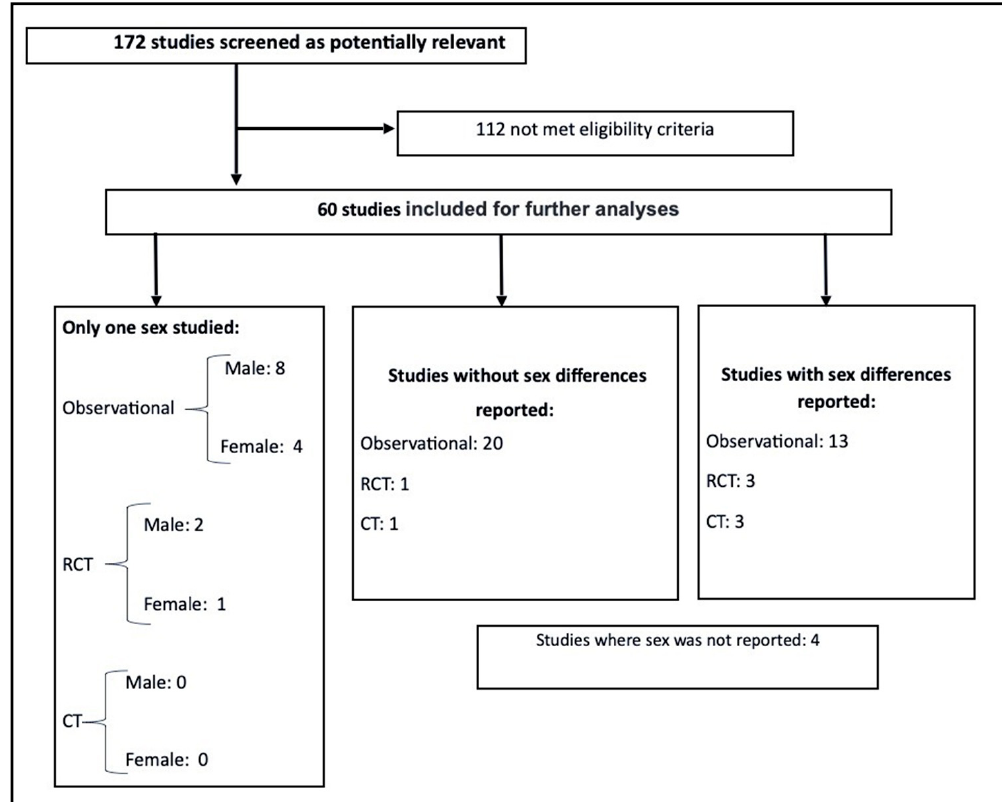
Figure 1. Preferred Reporting Items for Systematic Reviews and Meta-Analyses (PRISMA) flow diagram of literature search and selection process.